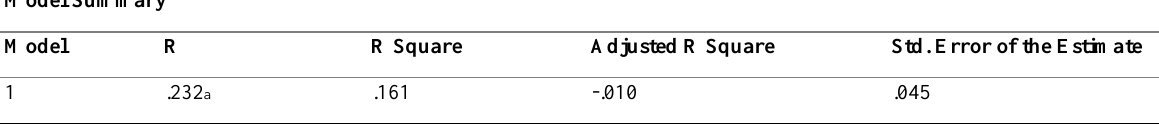
Table 4: Model Summary